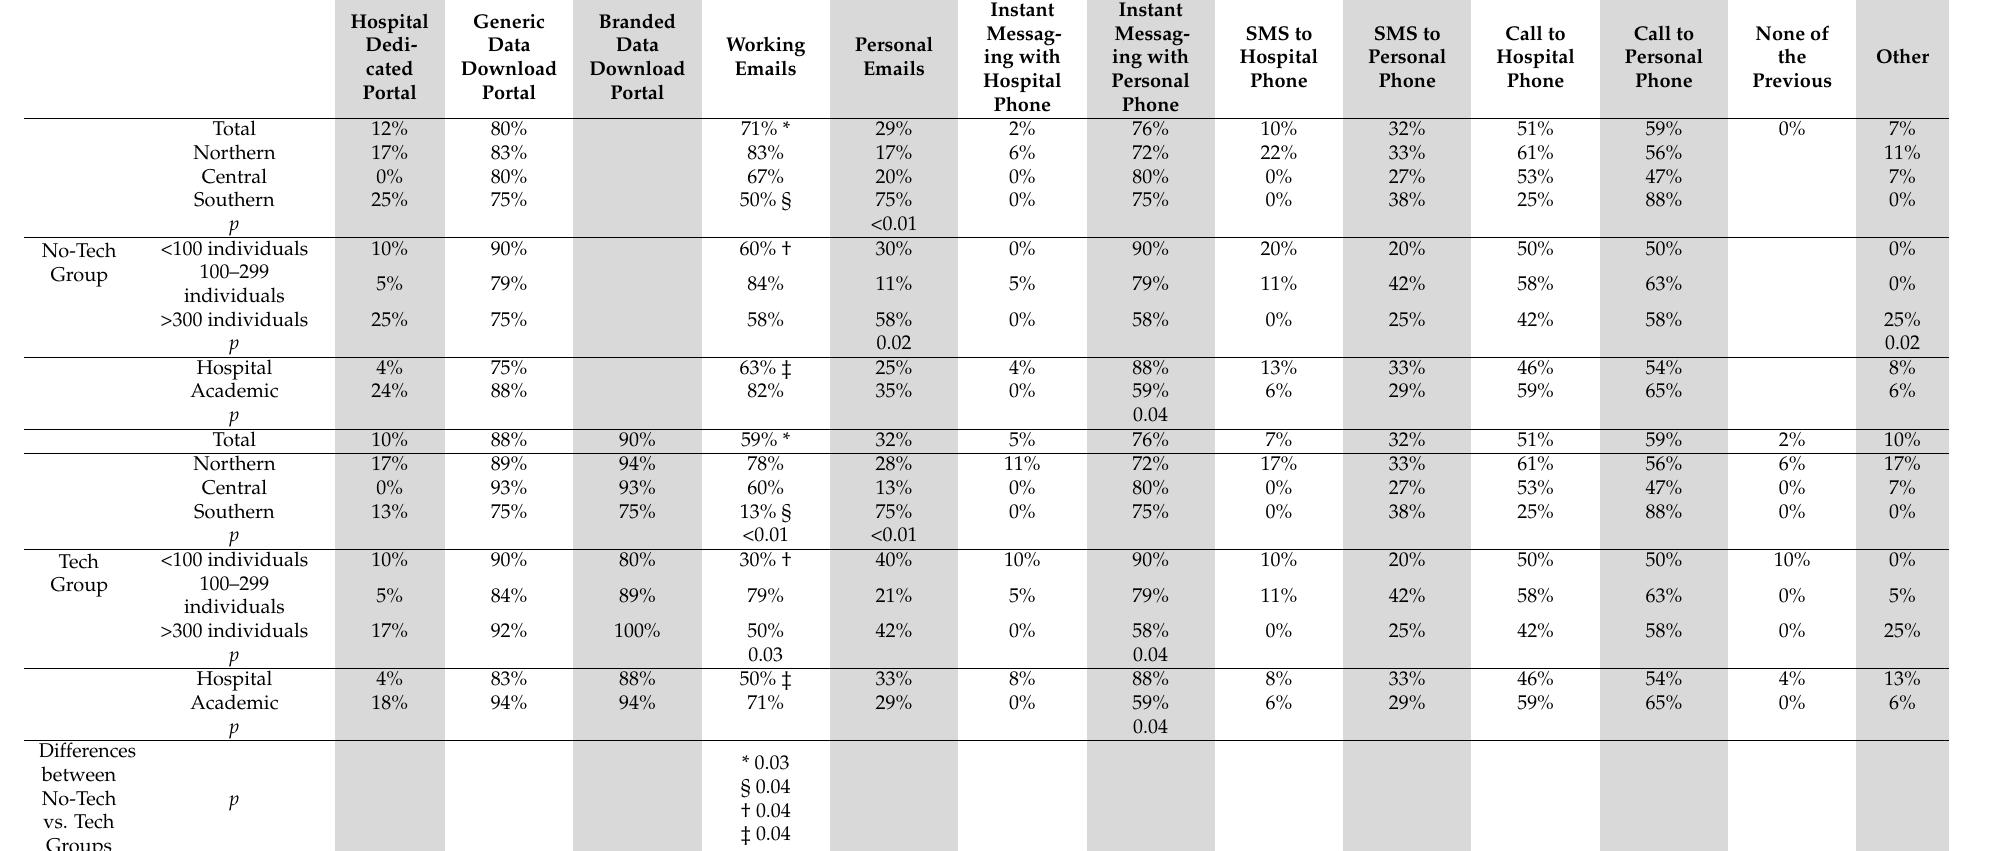
Table 2. Telemedicine methods used for the no-tech and tech groups according to the region, the number of patients with type 1 diabetes treated in the center, and the setting. “Others” in no-tech group: (1) Dedicated app on a smartphone; (2) paid consultation platform; (3) Skype/Webex. “Others” in the tech group: (1) “Visitami” app/Zoom; (2) dedicated app on a smartphone; (3) paid consultation platform; (4)